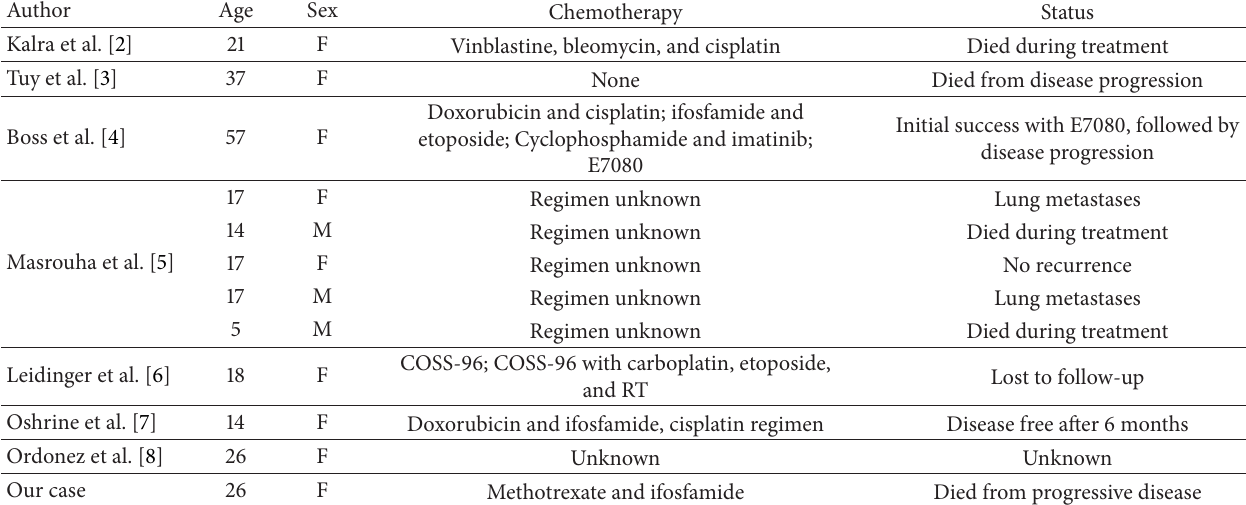
Table 1: Previously reported cases of 𝛽 -hCG producing